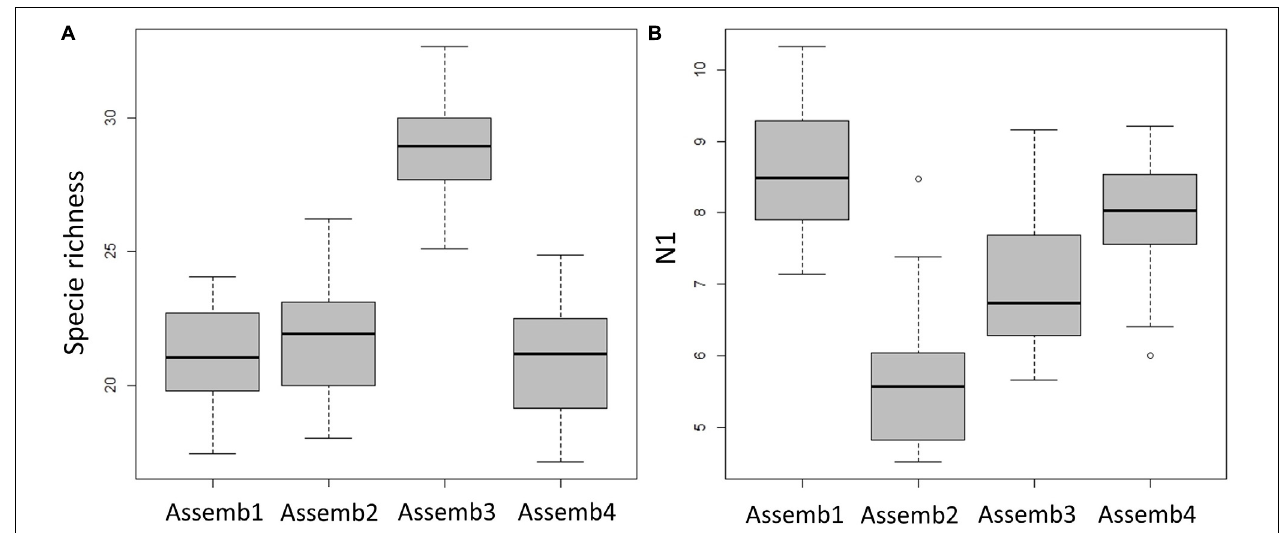
FIGURE 8 | Diversity indices for each demersal assemblage are showed as boxplot. (A) Species richness (number of species) and (B) Hill’s number N1 (modified Shannon diversity).